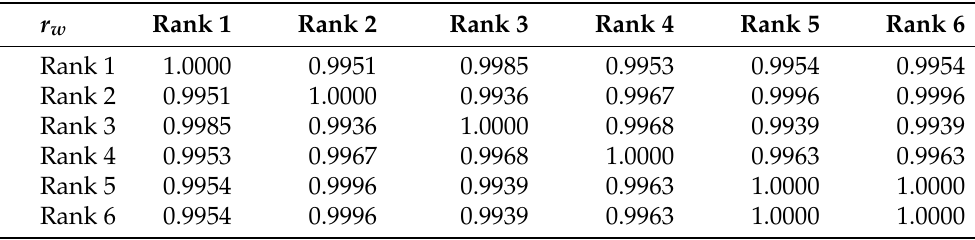
Table 10. Correlation matrix for r w values for compromise ranking candidates with consideration of sample smartphones.